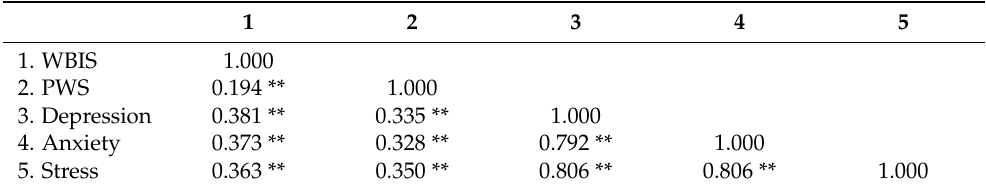
Table 5. Correlation Coefficients Between Internalized WS, PWS, and Psychosocial Stress ( n =